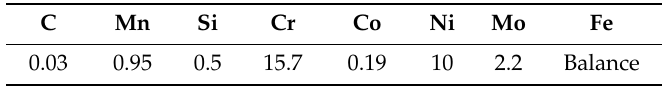
Table 5. Chemical composition of stainless-steel 316l (in weight percent wt%).